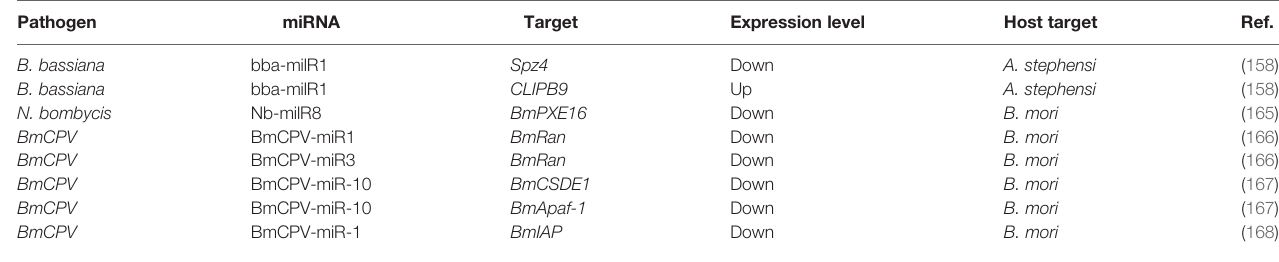
TABLE 3 | Pathogen-encoded ncRNAs targeting insect-derived genes.